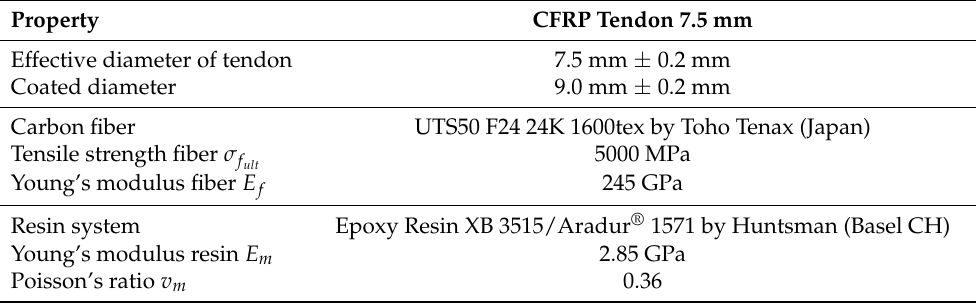
Table 1. Tendon material properties.